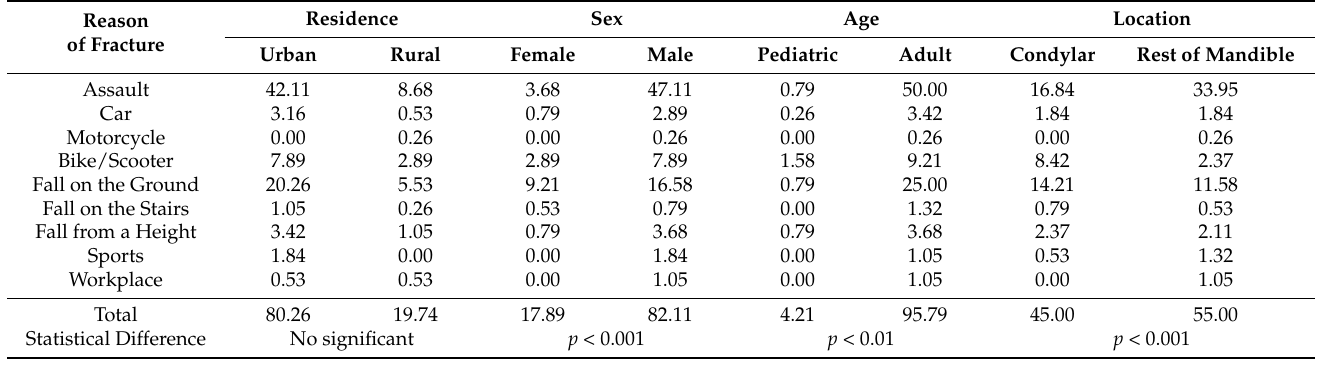
Figure 2. Distribution of causes of mandibular fractures by sex. Women had significantly more frac- tures due to falls, and men had significantly more fractures due to assaults ( p < 0.001). Figure 3. The relationship between the cause of injury and the occurrence of condylar fracture in the mandible. Note that fractures resulting from falls and vehicular accidents are more common ( p < 0.001) than the “intact” status of this anatomical region (i.e., they cause fractures of other parts of the mandible).